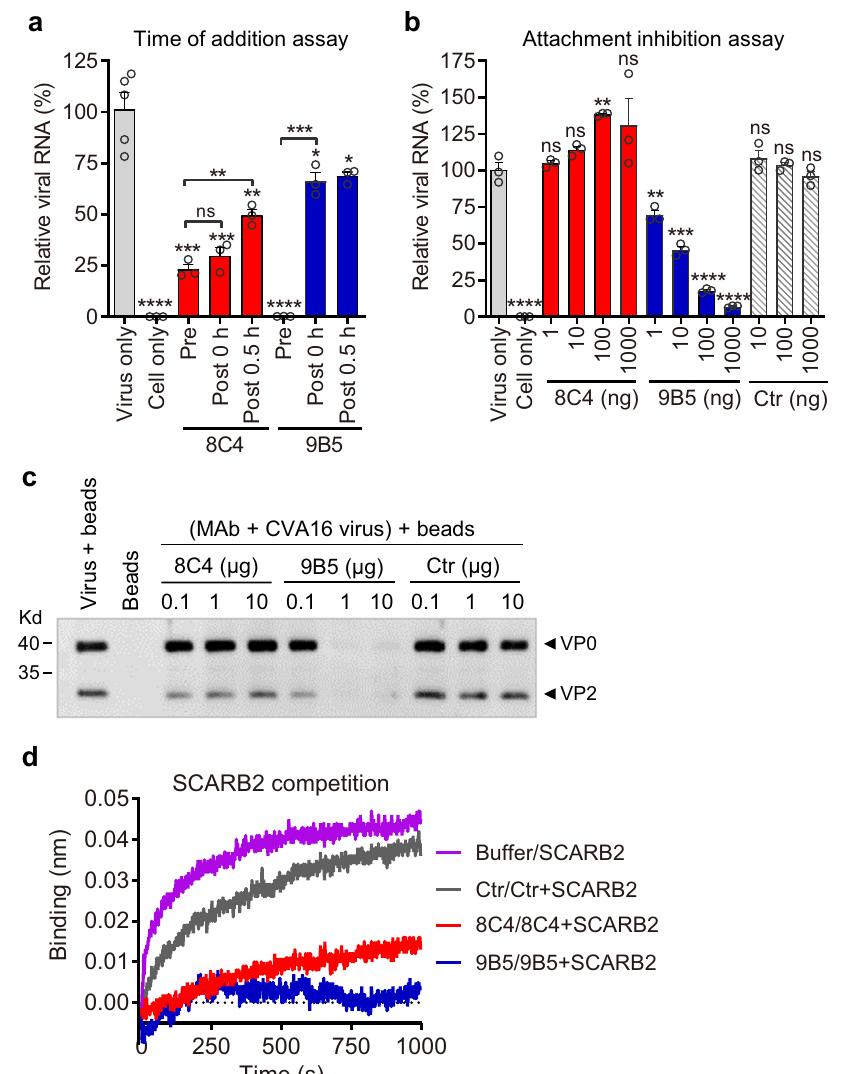
Fig. 3 | Mechanisms of neutralization of the MAbs. a Time of addition assay. CVA16/SZ05 was exposed to 8C4 or 9B5 before (Pre) or at different time points after (Post) the virus attached to pre-chilled RD cells. RNA was isolated at 6h after infection for real-time RT-PCR analysis of CVA16 RNA. b Attachment inhibition assay. CVA16/SZ05 was incubated with various amounts of 8C4, 9B5, or control [Ctr]antibody2H2for1h,andthemixtureswerecooledandthenallowedtoattach topre-chilledRDcellsfor1hat4°C.Afterrinse,RNAwasextractedforreal-timeRT- PCR analysis. In a , b , for each treatment, viral RNA levels relative to those for the only virus-infected samples are shown. Data are mean±SEM of at least triplicate wells ( n =5 for the virus-only group in a , and n =3 for each of the other